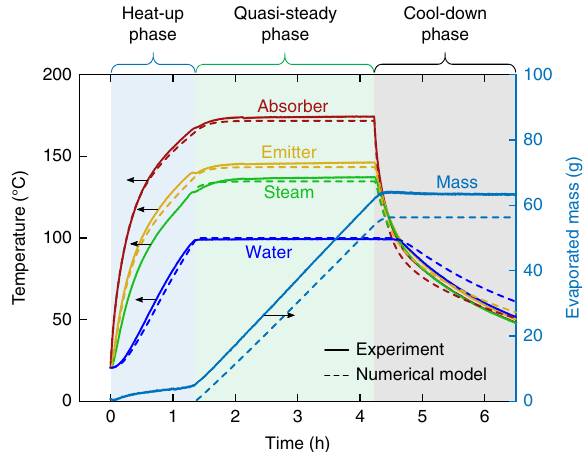
Fig. 3 Transient response of the CSES under 1.5 sun illumination. Experimentally measured (solid lines) and modelled (dashed lines) transient response of the absorber, emitter, water and steam temperatures for a representative experimental run at 1.5 suns. Also shown is the temporal evolution of the evaporated mass measured by a balance, and predicted by the transient model (Supplementary Note 5), which accurately predicts the mass fl ux during the quasi-steady phase. The small initial evaporated mass during the heat-up phase is partially attributed to evaporation of residual moisture in the porous materials, and is not accounted for the in the model which predicts the start of evaporation when T w reaches 100